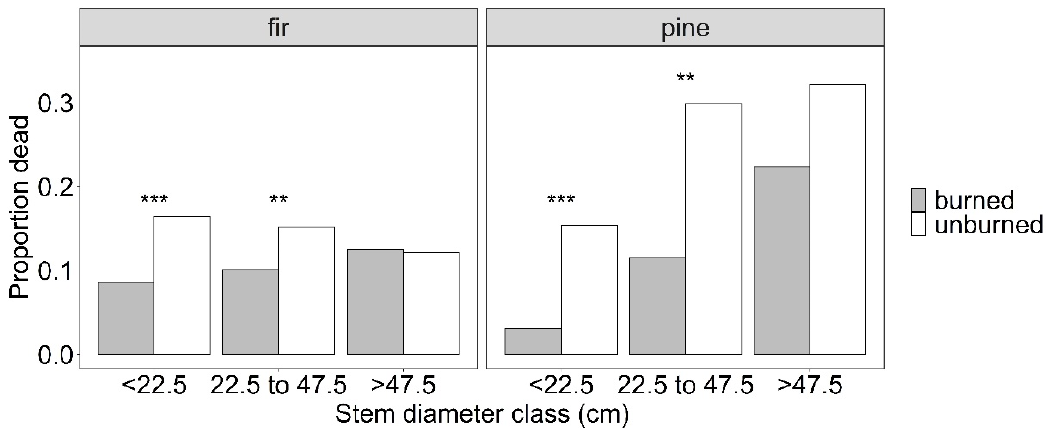
Figure 3. Proportions of trees that died in burned and unburned plots by species group and size class (Fisher’s exact test: ** p < 0.01, *** p < 0.001).